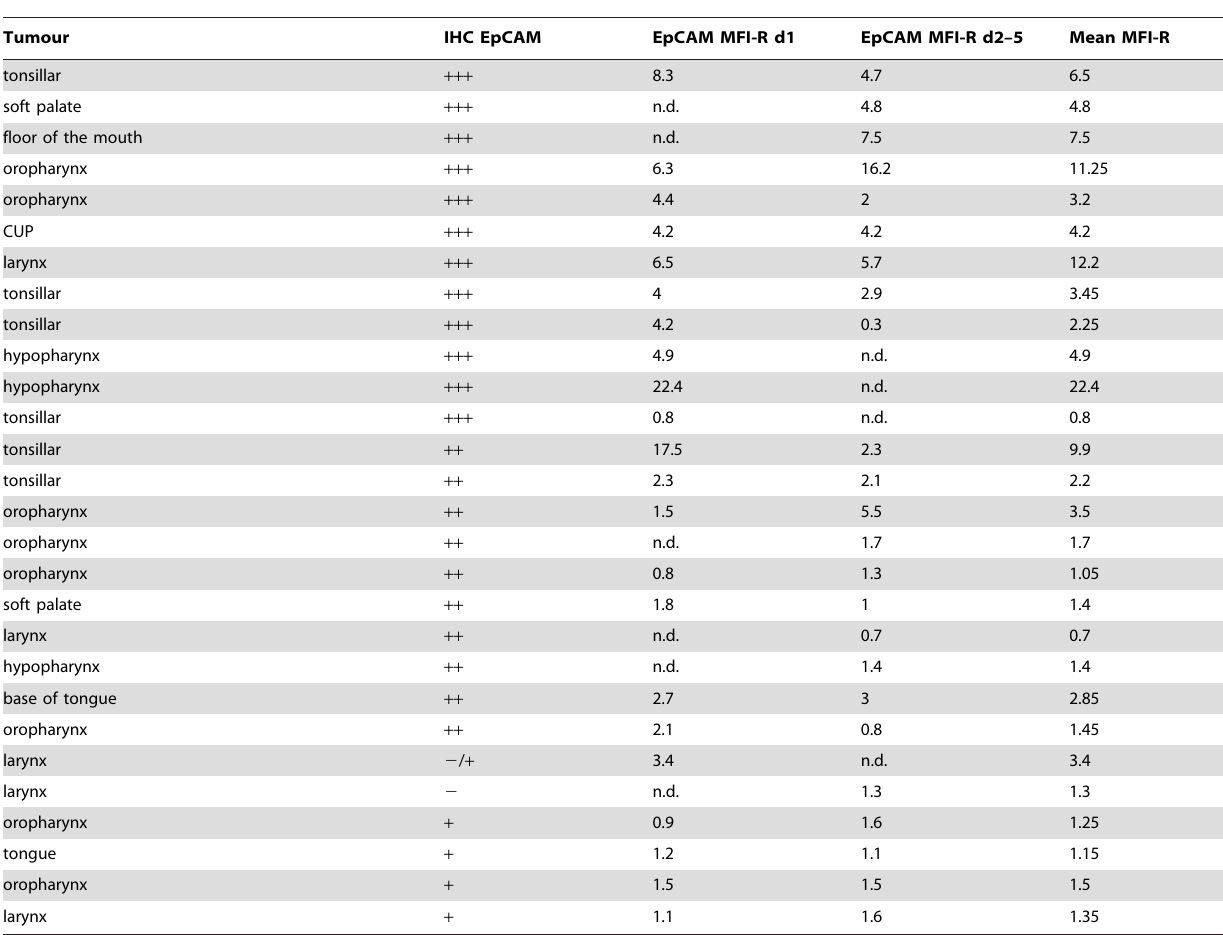
Table 1. Primary carcinomas used for the generation of